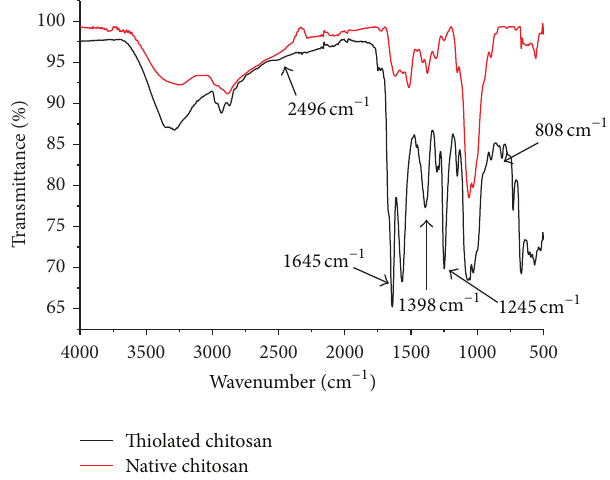
Figure 2: FT-IR spectra of thiolated chitosan and native